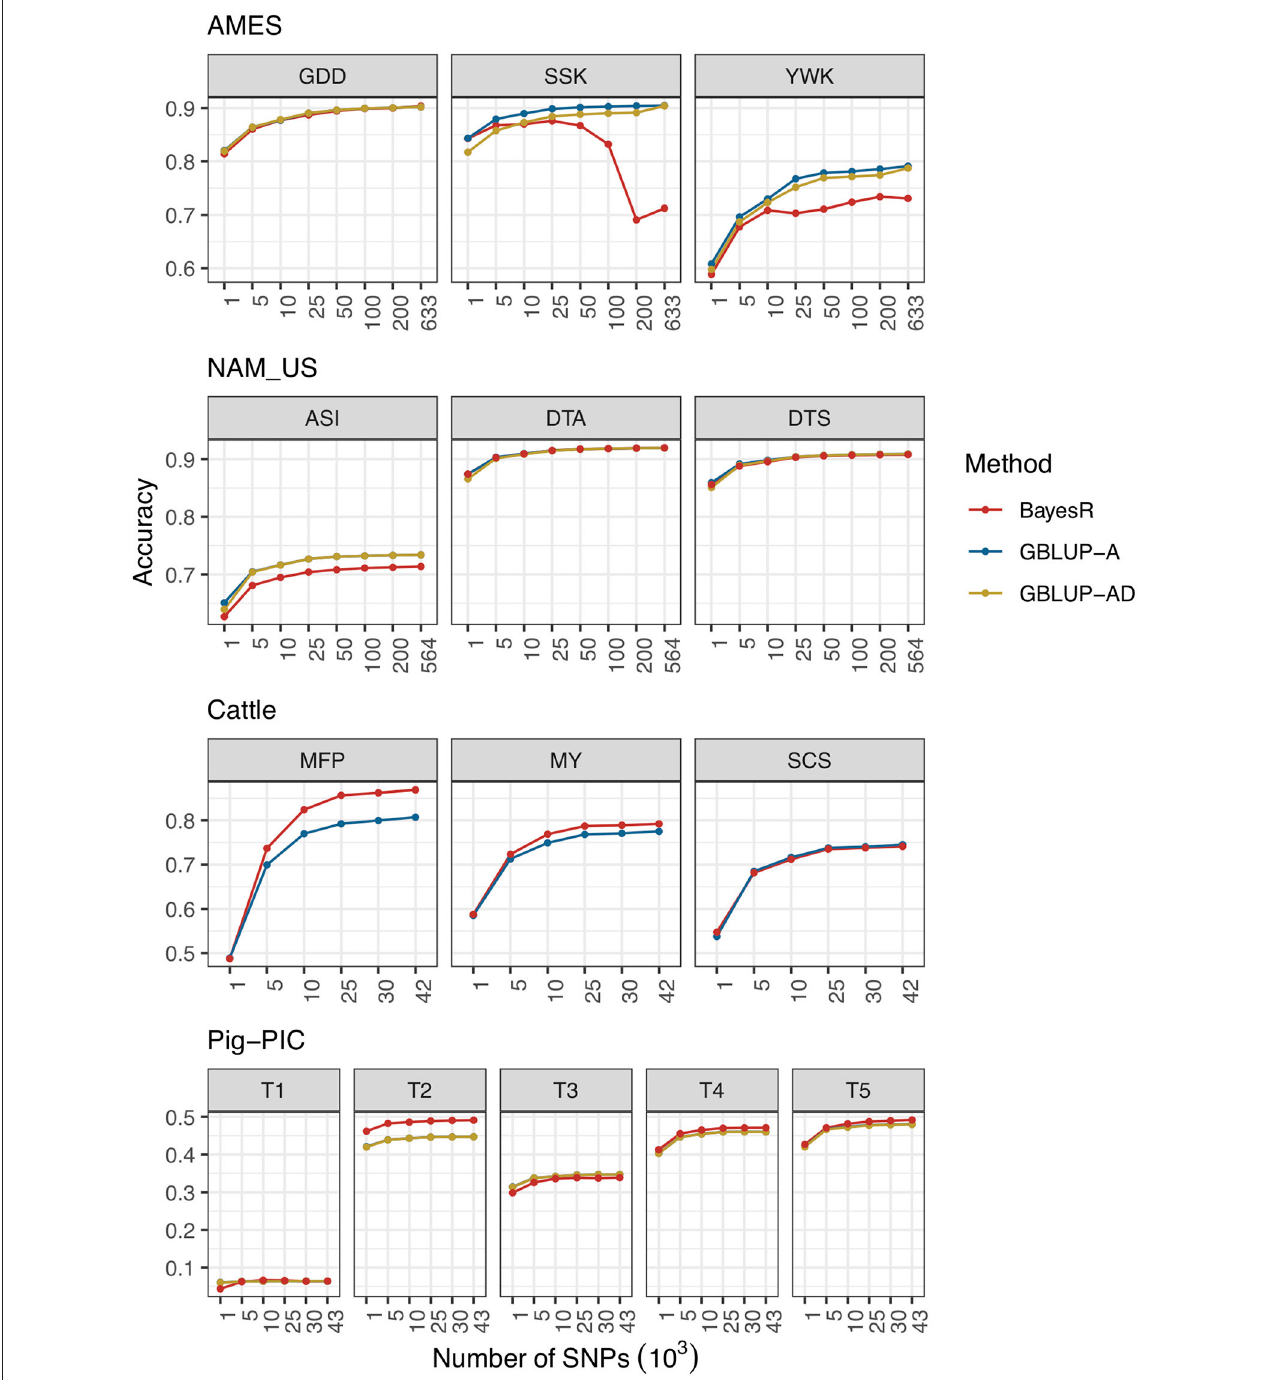
FIGURE 1 | Prediction accuracies of combinations of different level of marker densities and methods in four populations.